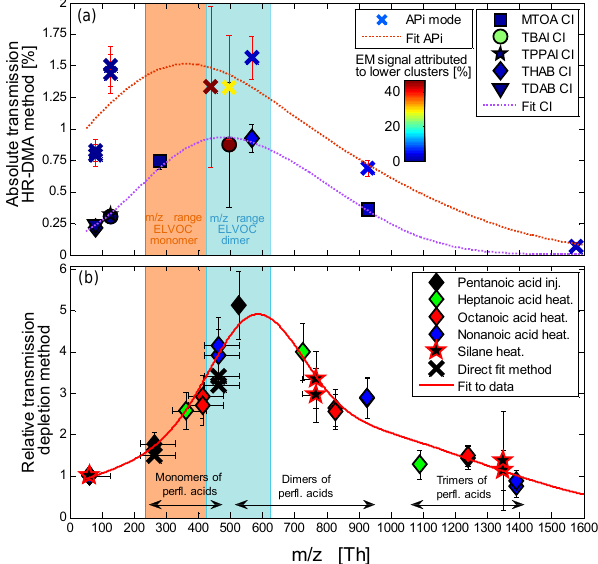
Figure 5. (a) Absolute transmission data obtained with the HR- DMA method for APi only (crosses) and CI mode. Each data point is the ratio of TOF signal to corrected EM signal of a certain clus- ter. Iodide containing dimers fragment significantly to I − , which enhances uncertainty. (b) Transmission curve obtained by deple- tion method with included mass discrimination effects of the CI source. The data points obtained with the direct fit method repre- sent lower limits of relative transmission. A least-squares fit to a 2-fold Gaussian distribution was applied to the data (direct fit data was not used for this fit). The transmission curve obtained by the de- pletion method changes significantly over the m/z range of ELVOC molecules, indicated by orange and blue shaded areas for ELVOC monomer and dimer,